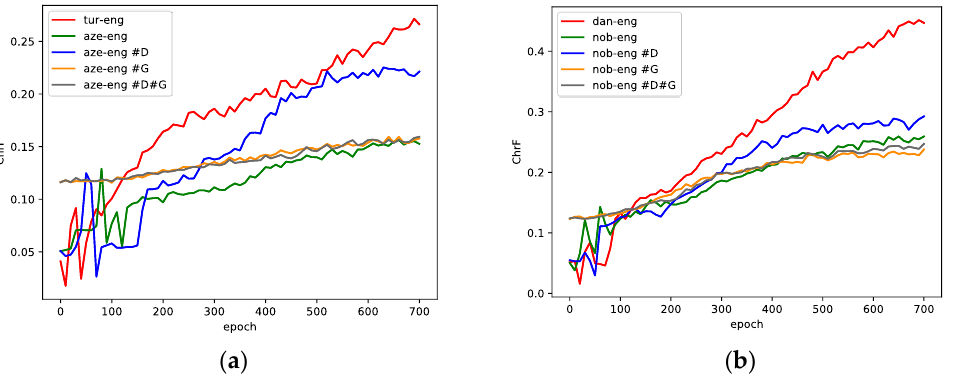
Figure 3. ChrF3 scores during the training: ( a ) transfer tur-eng to aze-eng, and ( b ) transfer tur-eng to aze-eng. The red line ( — ) is the reference language. The green ( — ), blue ( — ), gold ( — ), and gray ( — ) lines represent the non-transfer, transfer Generator, Discriminator, and both, respectively.